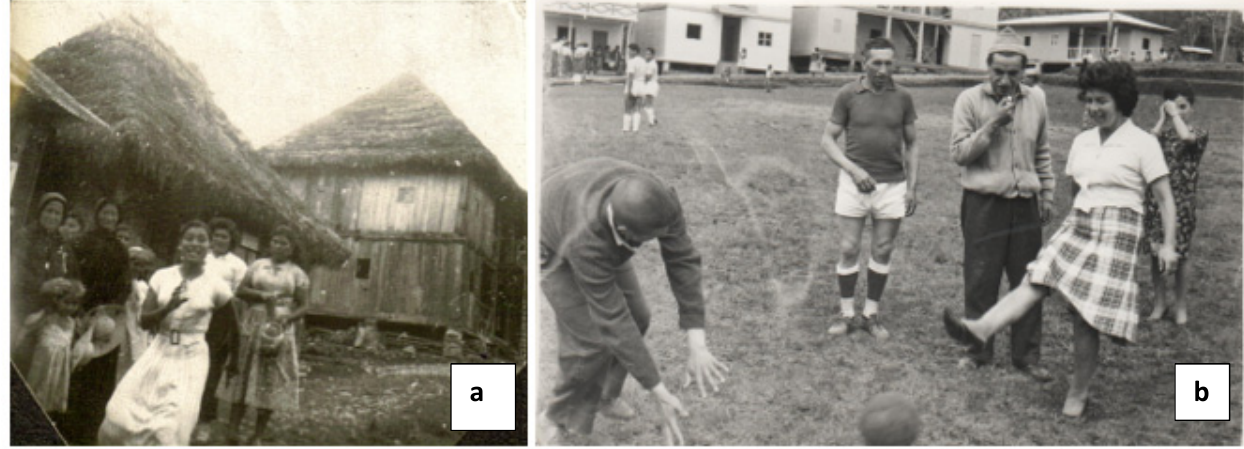
a b Figure 6. Women have been present in formalizing and promoting conservation programs and other sustainable development ventures in the area. The left picture ( a ) shows the original wooden structures with thatch roof, while on the right ( b ) the houses are already brick with metal roofs. Source ( a ) from Jack Rodríguez, Mar 1952. Source ( b ) from Jack Rodríguez, May September 1988.